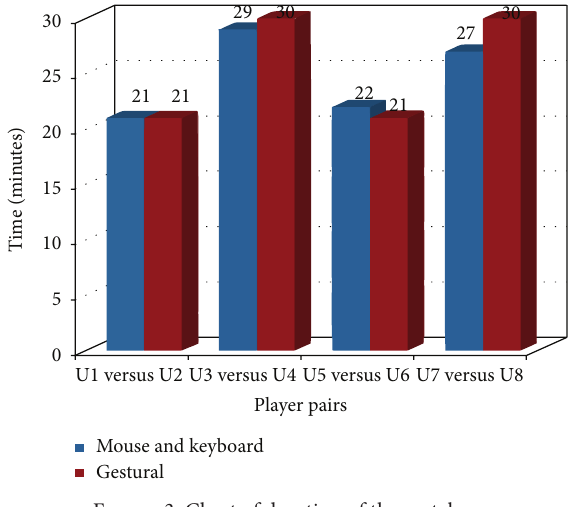
Figure 3: Chart of duration of the